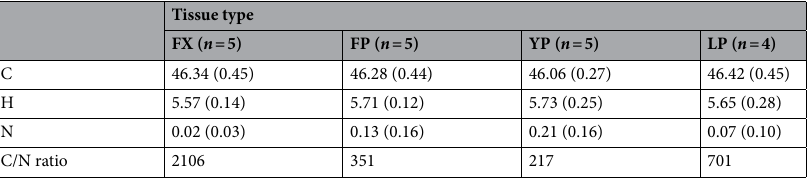
Table 3. The proportions of carbon (C), hydrogen (H), and nitrogen (N) and C/N ratio of Pleioblastus simonii bamboo tissues. Each value of C, H, and N represents the mean (SD) (%) of four or five internode samples. C/N ratio was calculated as (mean C/mean N). FX fresh xylem, FP fresh pith, YP pith on which Wickerhamomyces anomalus yeast had grown, LP pith on which W. anomalus and a larva of Doubledaya bucculenta had grown.